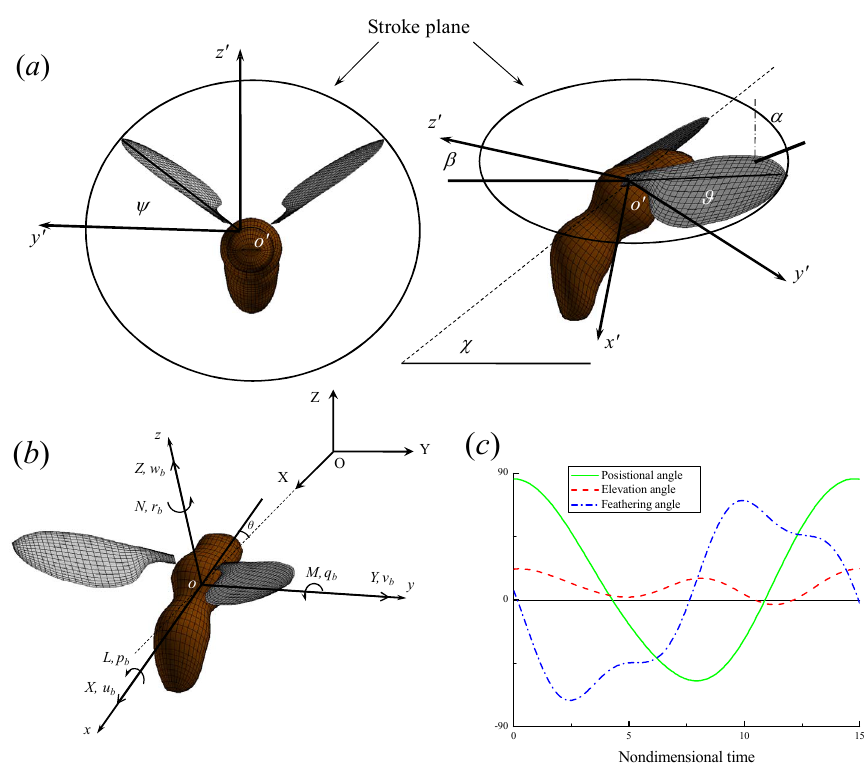
Figure 1. ( a ) Definition of 3D movement of a flapping wing: positional angle ψ around the x’ -axis; elevation angle θ around the z’ -axis and feathering angle α around y’ -axis. We assume a body angle χ of 45 o and a stroke plane angle β of 0 o . ( b ) The local body-fixed coordinates oxyz and the global earth-fixed coordinates OXYZ, in which Z-axis points to the opposite gravitational direction. Definitions of the aerodynamic force components ( F X , F Y , F Z ), aerodynamic moment components ( T X , T Y , T Z ) and the sate variables ( u b , v b , w b , p b , q b , r b ) under a body-fixed coordinates oxyz . The body-fixed coordinate is centered on the center of gravity with the x -axis being horizontal and pointing forward. Each of the vectors is signed positive in the direction shown. ( c ) Time variations of positional angle, elevation angle and feathering angle in constructing the wing-body